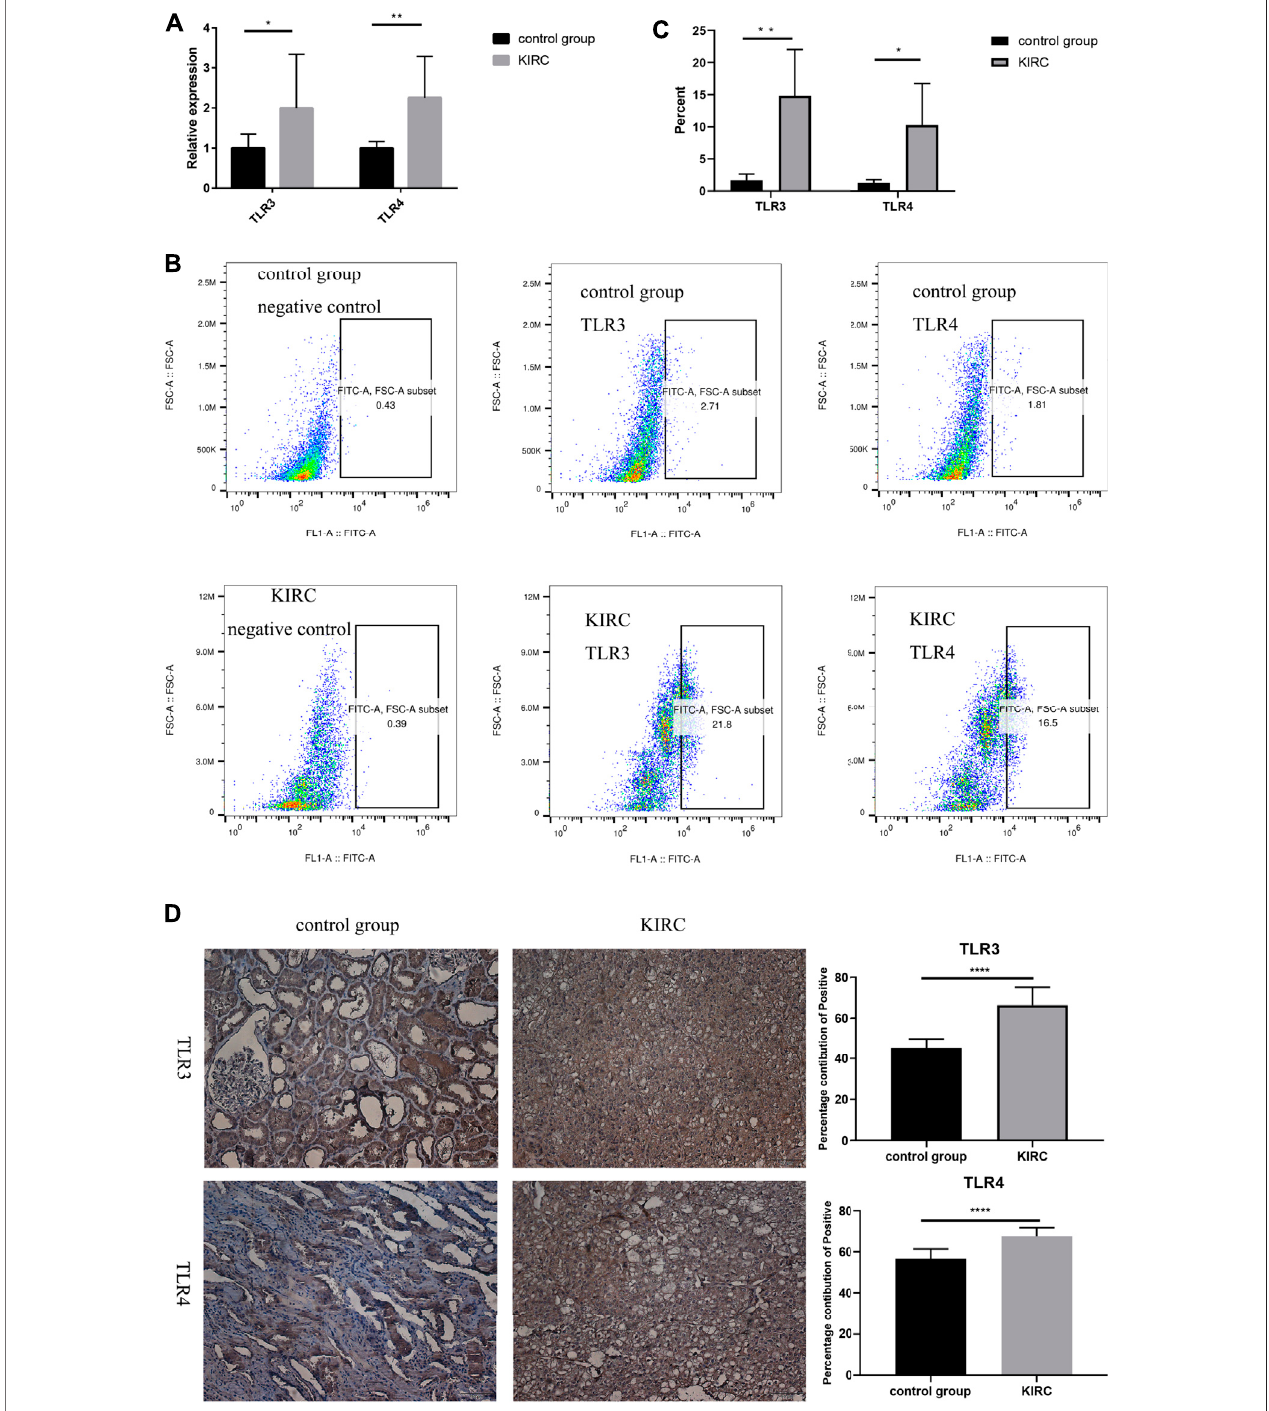
FIGURE 10 | Differential expressions of TLR3 and TLR4 in KIRC and adjacent nontumor tissues. (A) Expression levels of TLR3 mRNA and TLR4 mRNA in KIRC relative to adjacent nontumor tissues. (B, C) The proportion of TLR3 + or TLR4 + cells in KIRC and adjacent nontumor tissues was detected by fl ow cytometry. (D) The percentagecontributionofTLR3+orTLR4+cellsinKIRCandadjacentnontumortissueswasdetectedbyIHC.Controlgroup:adjacentnontumortissues.* p < 0.05;** p < 0.01; *** p < 0.001; **** p < 0.0001.